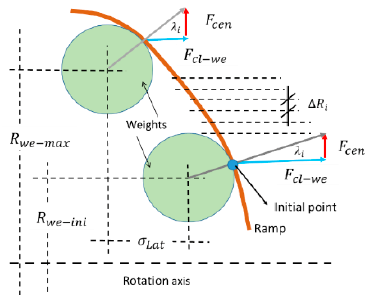
Figure 10. Diagram of axial force (F cl_we ) derived from the centrifugal force due to the ramp.